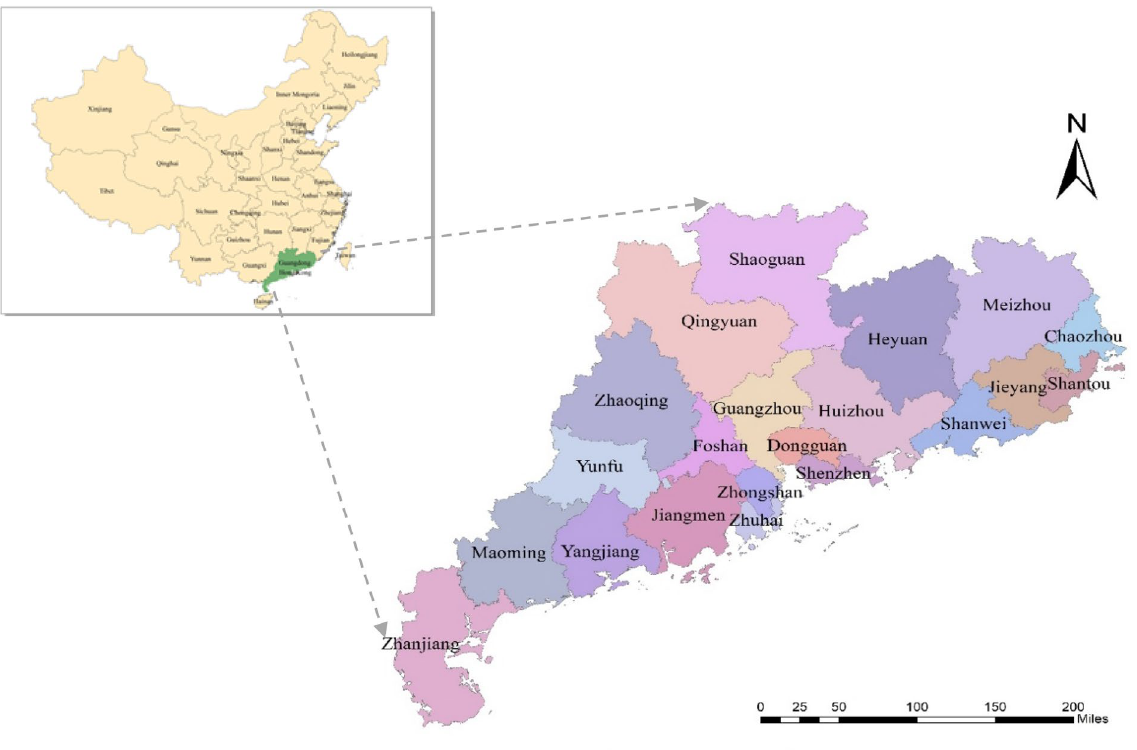
Figure 1. Geographical location of Guangdong Province and its 21 cities. Figure was made in ArcGIS 10.2 (https:// suppo rt. ersi. com/ en/ dowlo ad/ 2093). The dada source of administrative and city names was derived from the online open-source